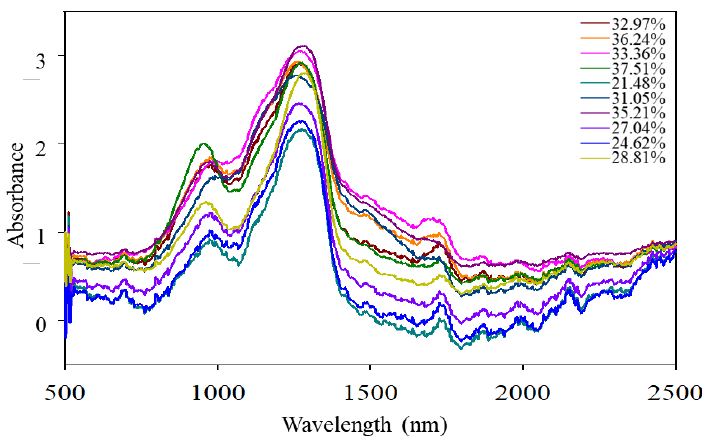
Figure 6. NIR raw spectrum of sweet potatoes with low moisture content (legend shows moisture content of sweet potatoes).